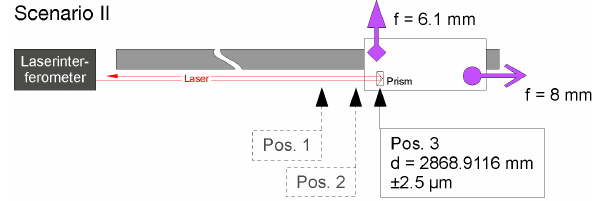
Figure 9. Schematic layout of the experiment and example for image acquisition with configuration 2 at position